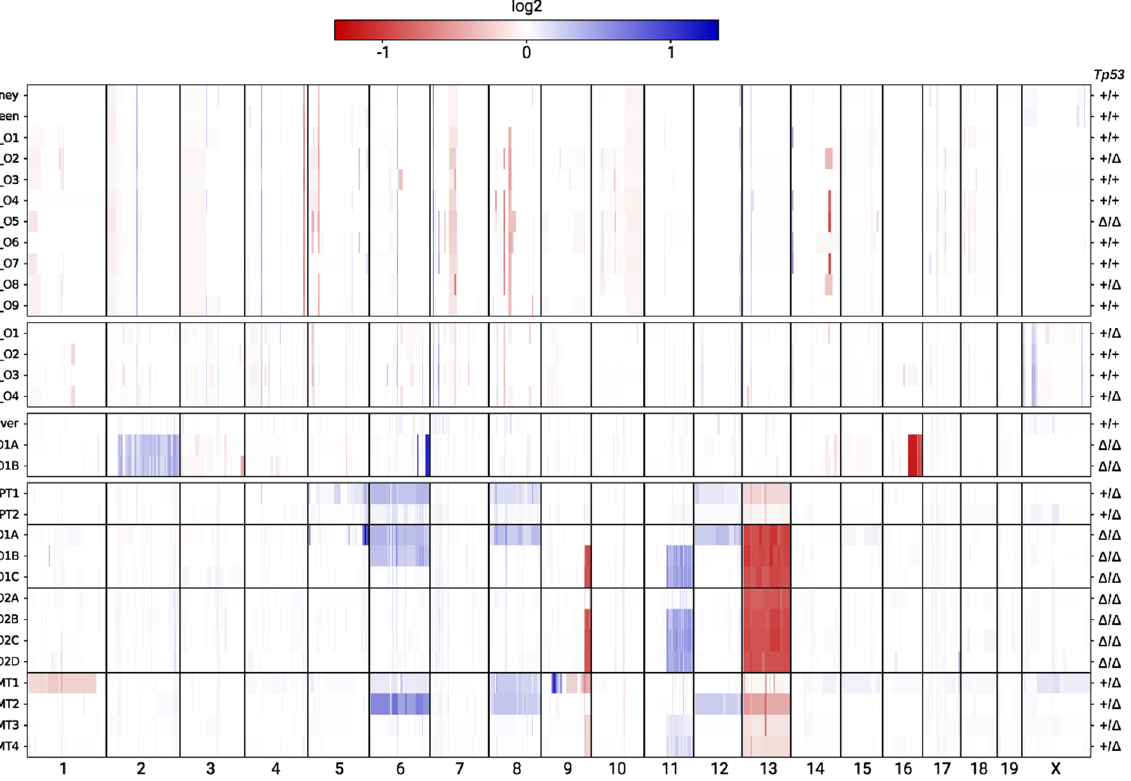
Figure 5. Profiles of copy number alterations (CNAs) in the tumour organoids and tissue biopsies from mice I-IV of this study. Red and blue colours correspond to deletions and duplications, respectively, and colour saturation indicates the ratio of the number of reads in the organoid or biopsy compared to the normal reference tissue. The allele status of Tp53 is indicated on the right side of the panel. The primary and metastatic tumours of mouse IV were homozygous for Tp53 deletion. However, the signal was diluted due to contamination by normal cells, and hence, these cases are indicated as +/ Δ .